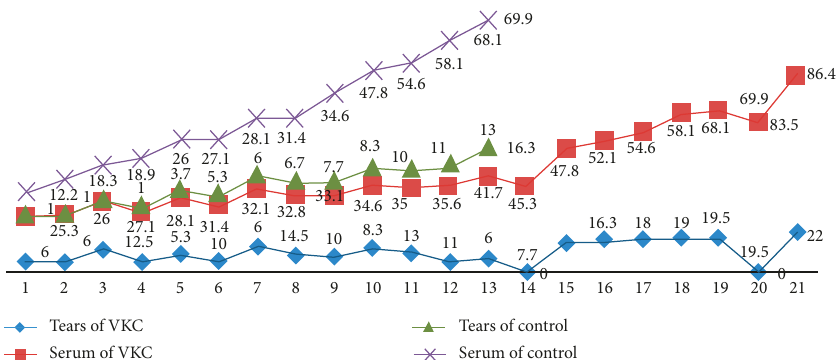
Figure 2: EIA values for VEGF concentration in tears and blood in control and vernal keratoconjunctivitis (VKC) groups. T ABLE 2: Comparisons of the 2 groups after using the VEGF EIA kit for vascular endothelial growth factor (VEGF) concentration. VKC group ( N � 21) Control group ( N � 13) p value VEGF tears in pg/mL: 12.13 ± 5.54 Tears in pg/mL: 7 ± 4.76 < 0.05 (0.011) VEGF serum in pg/mL: 45.17 ± 18.67 Serum in pg/mL: 38.08 ± 19.43 NS > 0.05 (0.29)